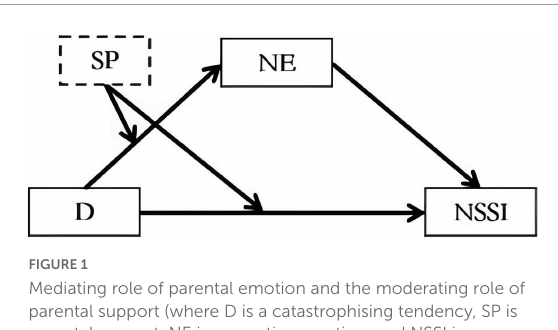
FIGURE1 Mediating role of parental emotion and the moderating role of parental support (where D is a catastrophising tendency, SP is parental support, NE is a negative emotion, and NSSI is non-suicidal self-injury).